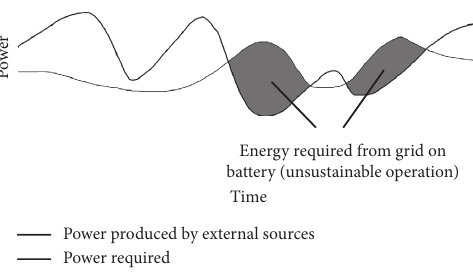
Figure 1: Profile of energy required and energy available from external sources. The unsustainable operation can be caused by the imbalance of available and required power, in which case additional energy needs to be extracted from the battery